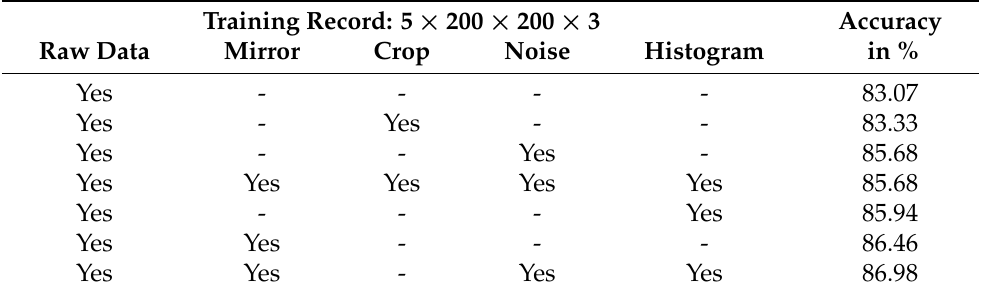
Table 4. Achieved accuracies of video classification on the test dataset, using different combinations of the training dataset.